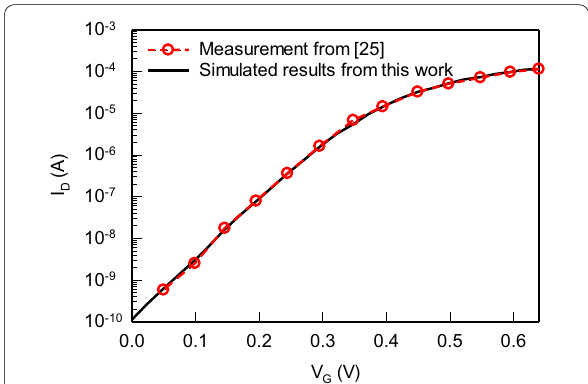
Fig. 1 The calibrated I D – V G curve between the simulation (black line) and the measurement (red symbol) of the N‑type nanosheet MOSFET with gate length of 12 nm at V D of 0.7